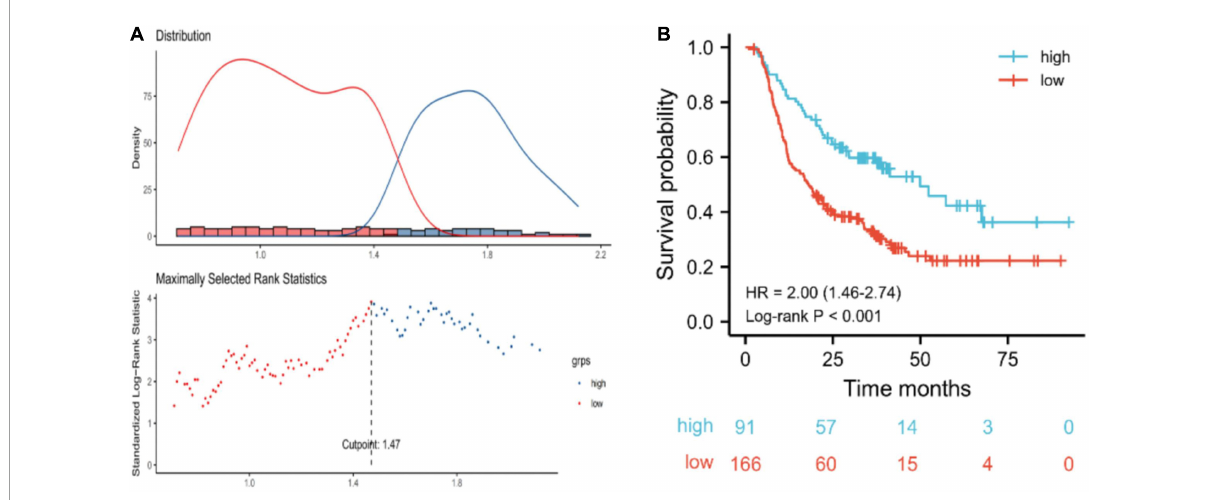
FIGURE2 (A) Optimal cut-off points were determined using an outcome-oriented method. (B) Overall survival of esophageal squamous cell carcinoma patients based on post-triglyceride (TG) cut-off. For post-TG, low: < 1.47 mmol/L; high: ≥ 1.47 mmol/L.